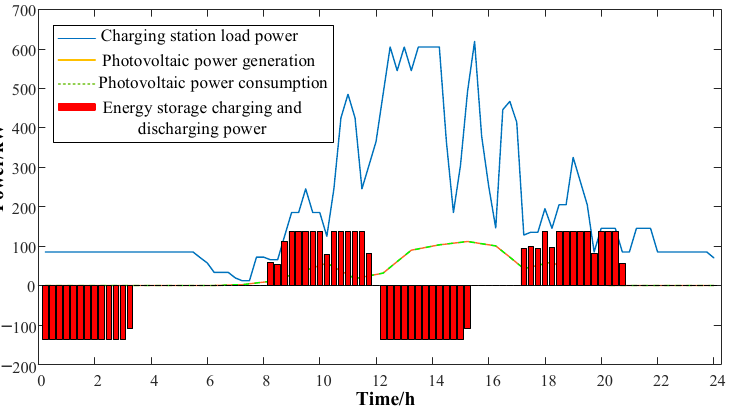
Figure 6. Load power, PV power, PV power consumption and optimal charge/discharge power curves for energy storage in Scenario I.